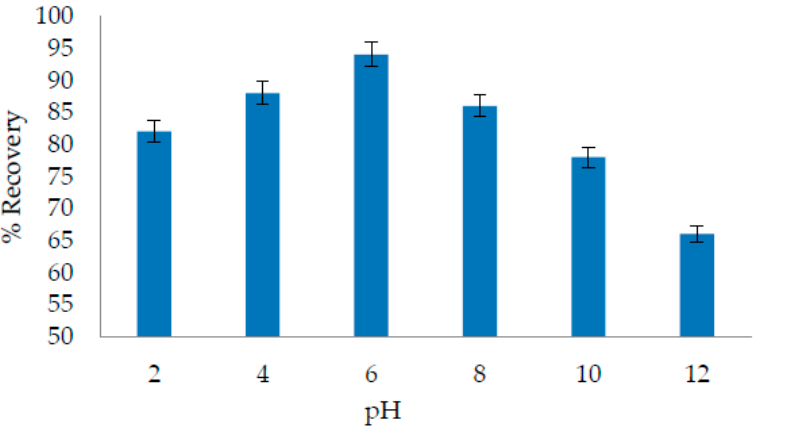
Figure 1. Optimization of pH. Buffer volume-2 mL; sample volume-20 mL; analyte concentration- 20 µg/L; DES volume-500 µL; THF volume-300 µL; temperature-25 °C; sonication time-2 min; centrifugation time-1 min.